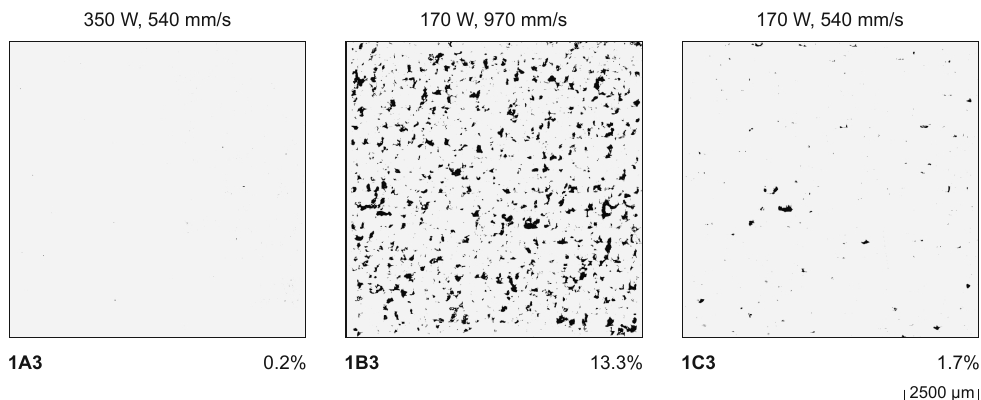
Figure A1. Display of porosity for the first replication of specimens.